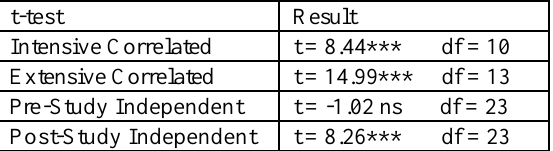
Table 4.9 Multiple Chose + True/False Questions